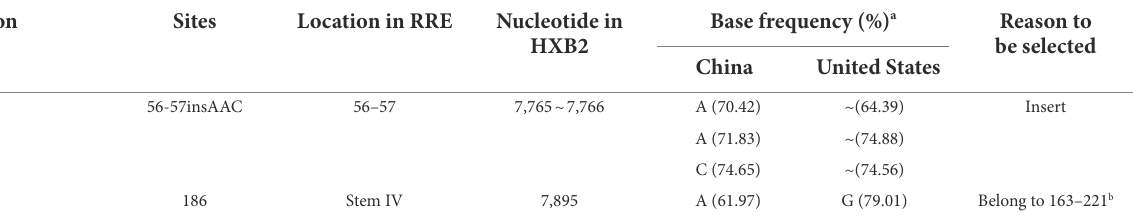
TABLE 4 Analysis and statistics of subtype specific loci of RRE.